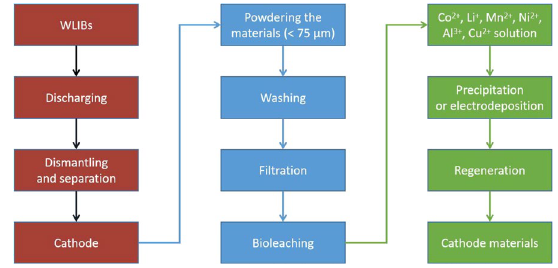
Fig. 3 A process flowsheet for bioleaching